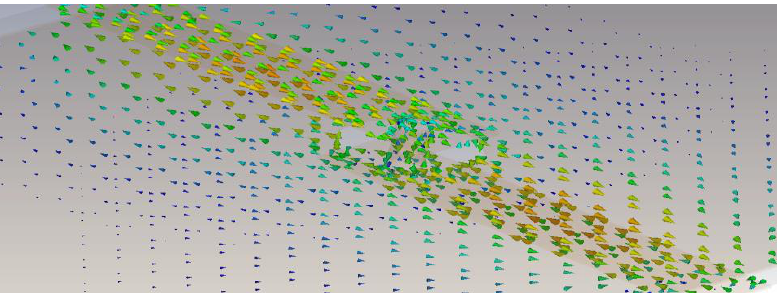
Figure 14. Surface current distribution from one layer to another using via-hole pin.